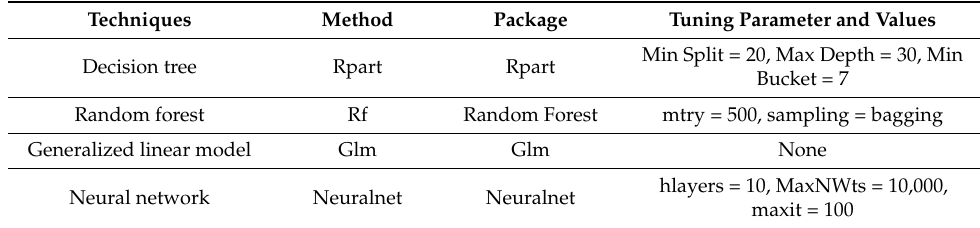
Table 6. Machine learning techniques.